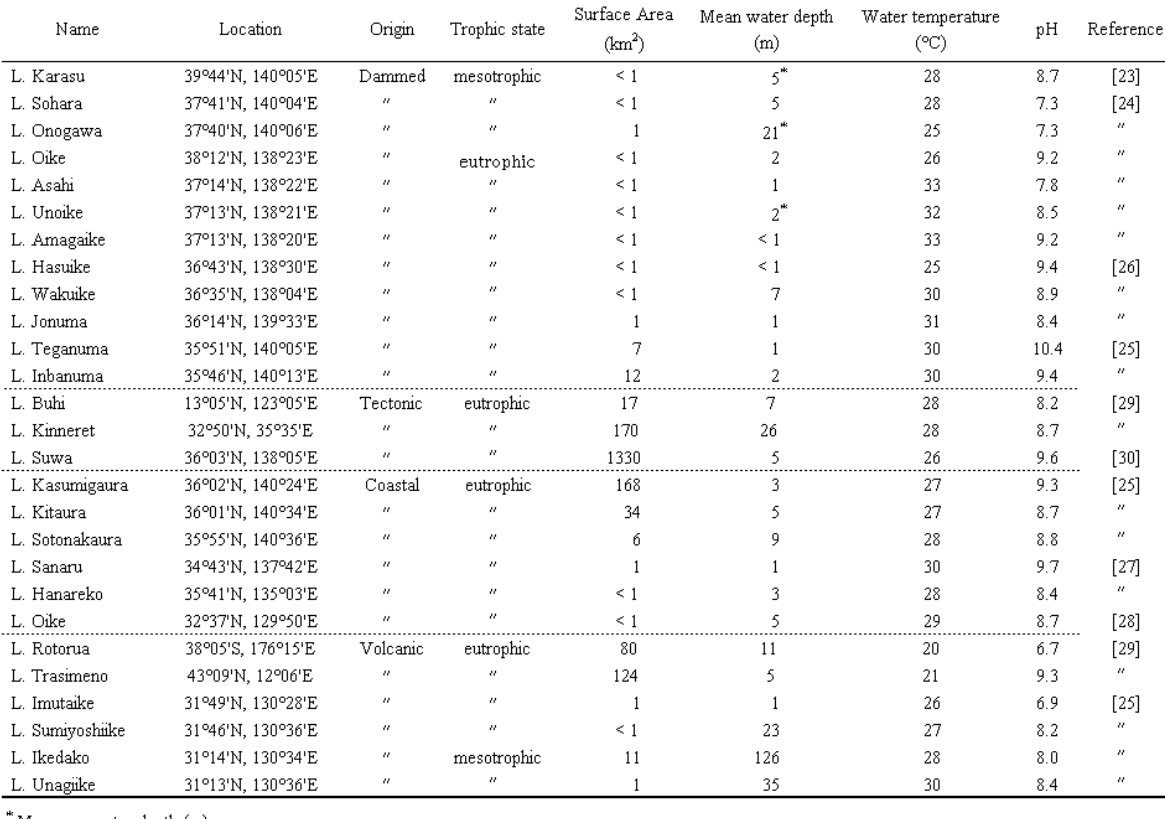
Classifications of Worldwide Natural Lakes where Microcystis has Appeared Based on Lake Origin and Trophic